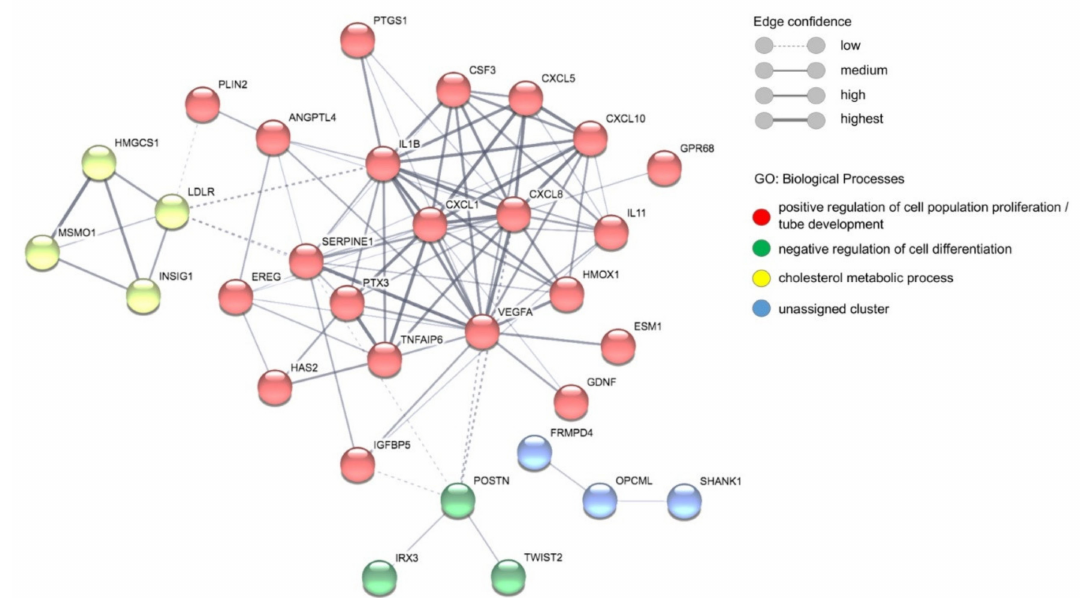
Figure 6. Detection of protein–protein networks through Markov Clustering (MCL) using STRING: functionalprotein association networks [49,50]. Proteins that have not been assigned to a network are not included in the figure. The proteins with a red circle can be assigned to ‘positive regulation of cell population proliferation’ and ‘tube development’, proteins with a green circle can be assigned to ‘negative regulation of cell differentiation’, and proteins with a yellow circle can be assigned to ‘cholesterol metabolic process’ within the gene ontology terms biological processes (GO:BP). Proteins with a blue circle belong to an unassigned